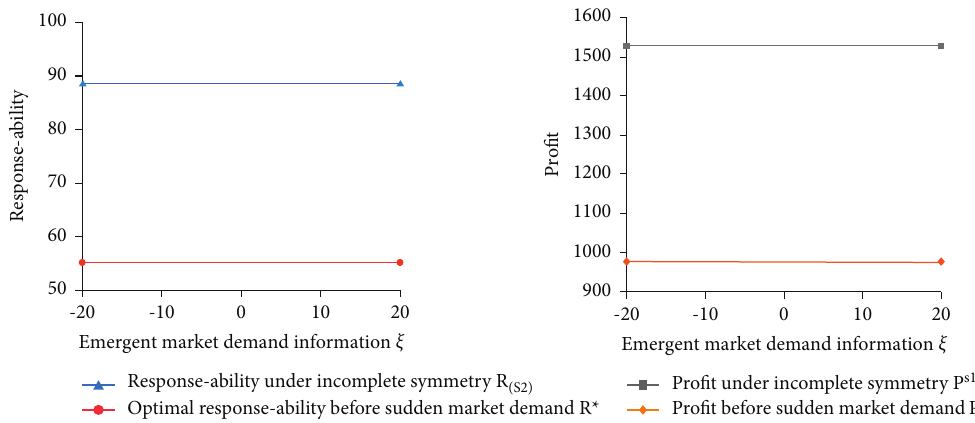
Figure 2: The change of supply chain’s profit and response ability under incomplete symmetrical information before and after an